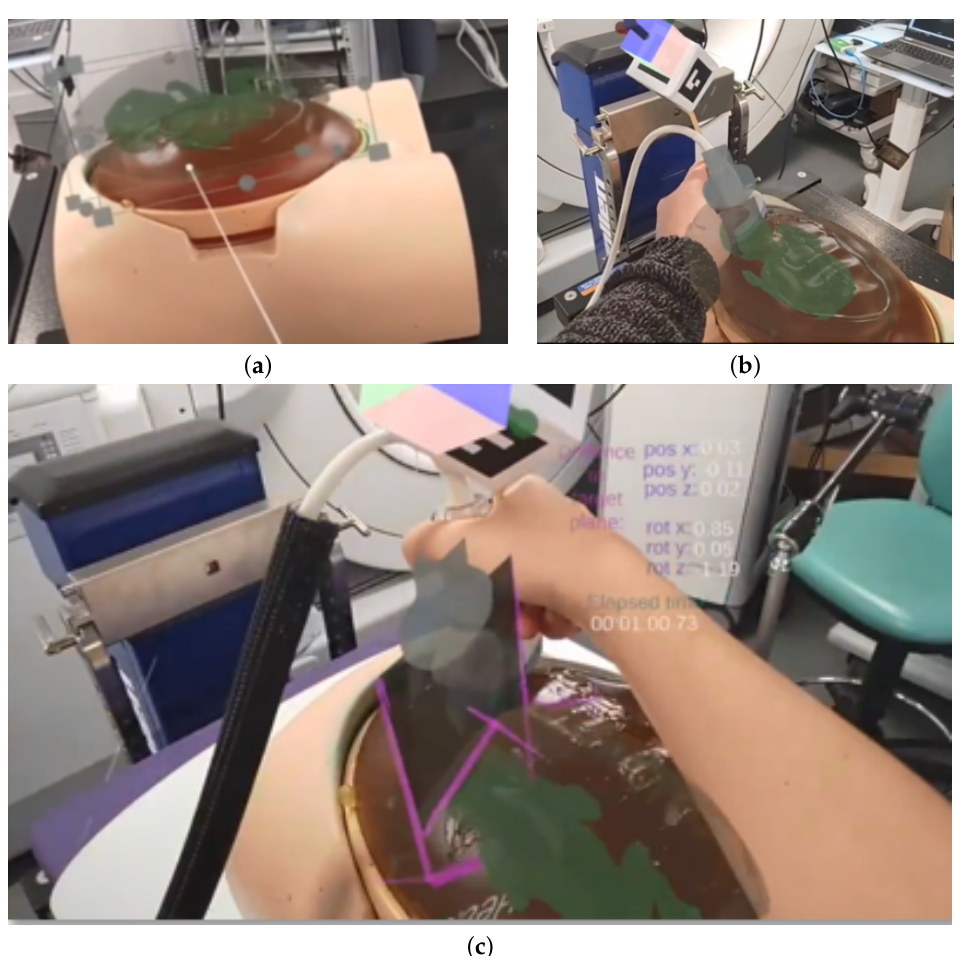
Figure 3. Illustration of the CAL-Tutor’s user work flow phases, shown from the HoloLens 2 perspective: ( a ) The initial manual registration of the baby model (by the expert); ( b ) the manual placement of the holographic standard planes at their respective baby locations (by the expert); and ( c ) trainee navigation to the standard